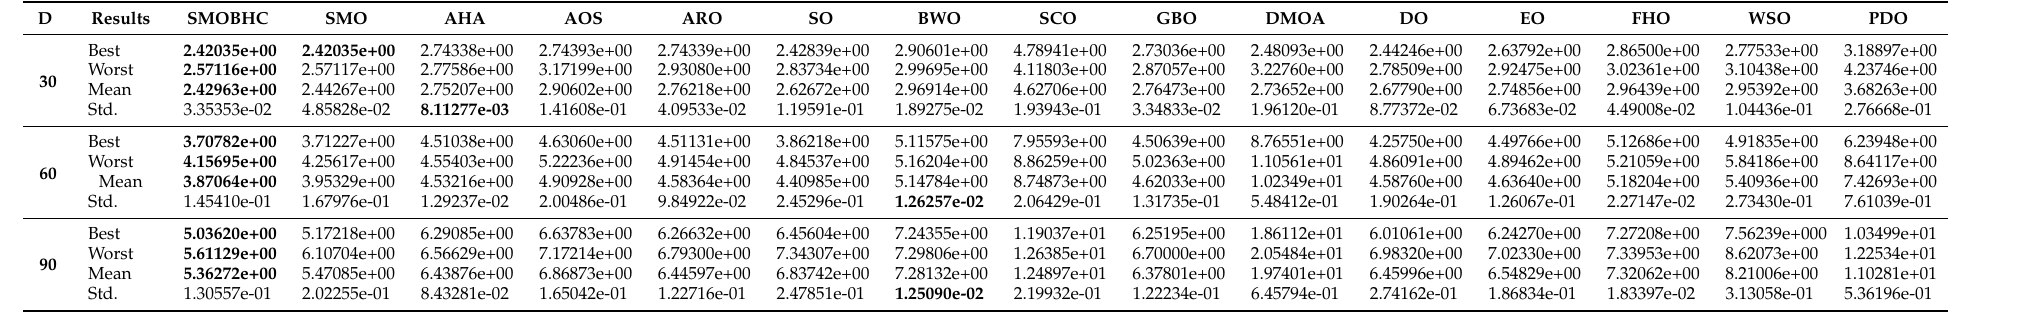
Table 7. Experimental results obtained for the fifteen experimented algorithms relative to three different problem dimensions equal respectively to 30, 60, and 90 for the third battlefield composed of twenty threats.